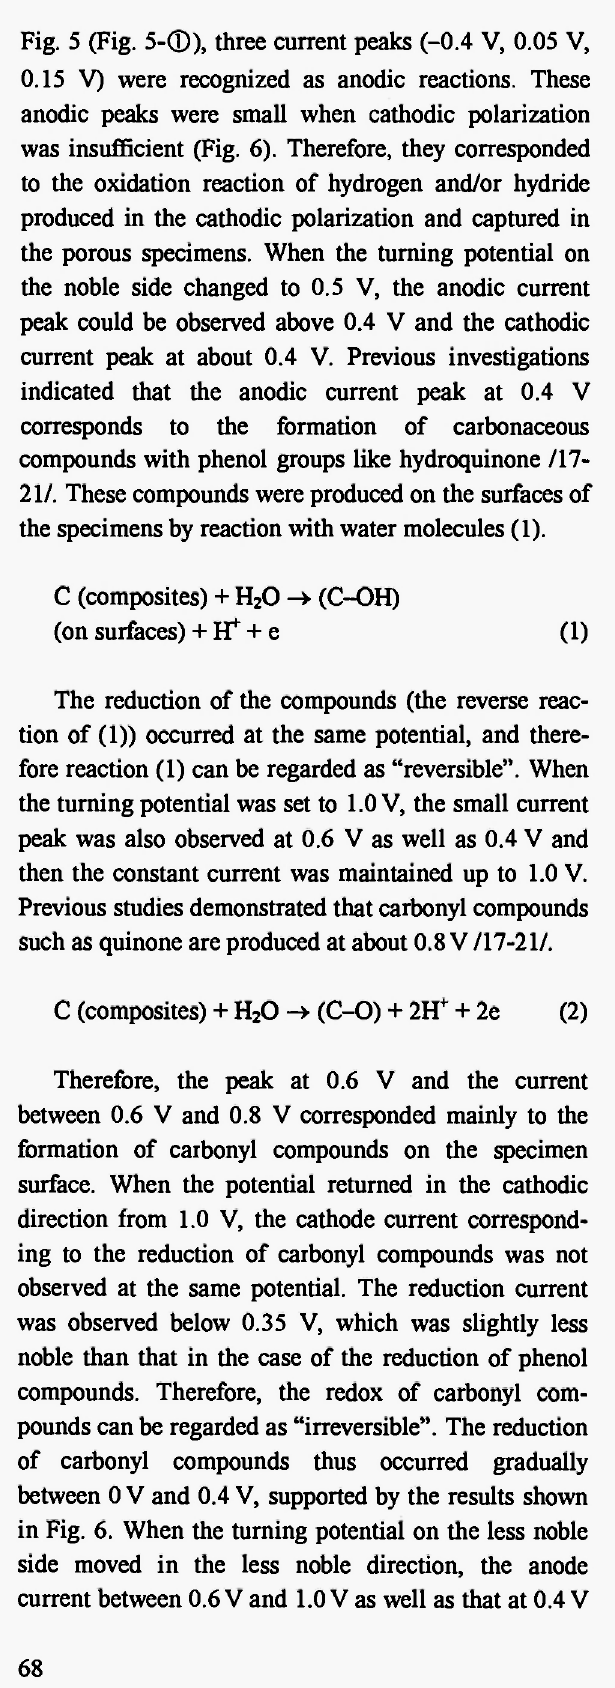
Fig. 5 (Fig. 5-φ), three current peaks (-0.4 V, 0.05